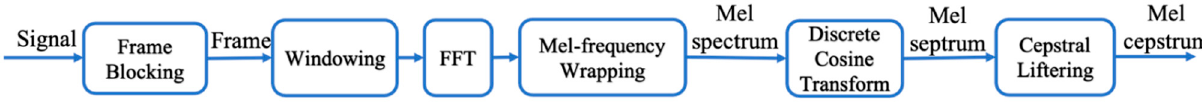
Figure 8. MFCC feature extraction technique.